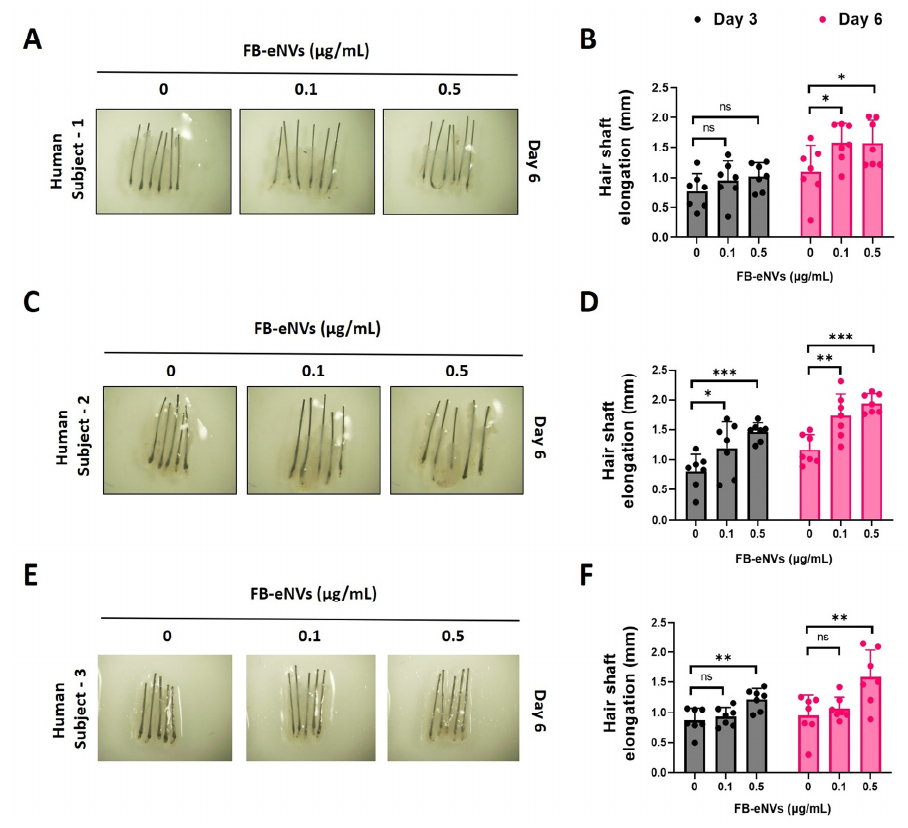
Figure 7. FB-eNV treatment promoted hair shaft elongation. ( A , C , E ) Representative images of human hair follicles after FB-eNV treatment (0, 0.1, and 0.5 µ g/mL) at day 6. ( B , D , F ) Quantified data of hair shaft elongation on day 3 and day 6 ( n = 6–7). The values are mean ± sd of a minimum of three replicates of an experiment. Student’s t -test was used. * p < 0.05; ** p < 0.01; and *** p < 0.001. ns: not significant.